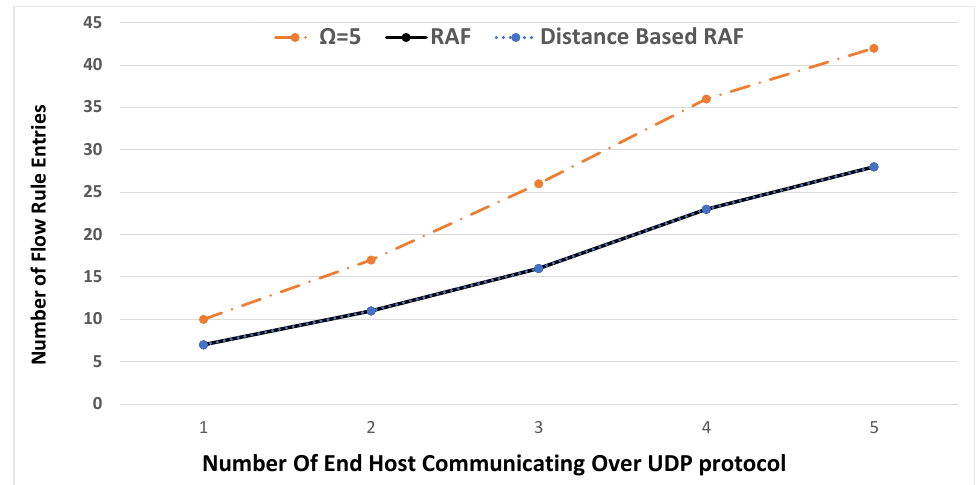
Figure 5. OpenFlow-enabled switch memory.